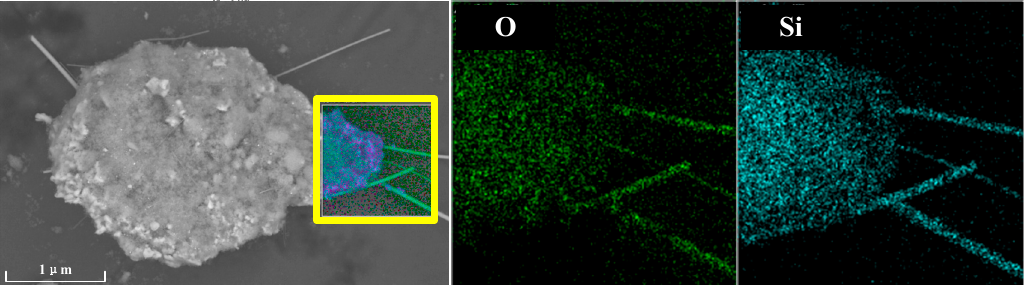
Figure 12. Electron microscope and energy spectrum analysis of white floc.